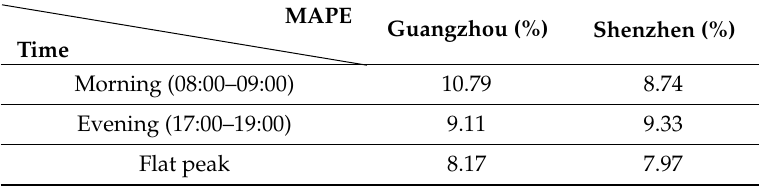
Table 5. Comparison of the results of the model for Guangzhou and